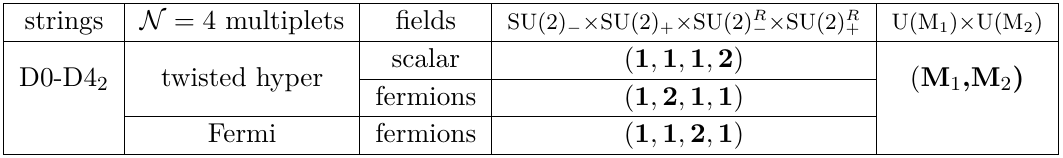
Table 3 . The quantum mechanical fields from the D0-D4 2 strings. These will introduce local operators that we can integrate out to form 1-loop determinants — see (4.15).